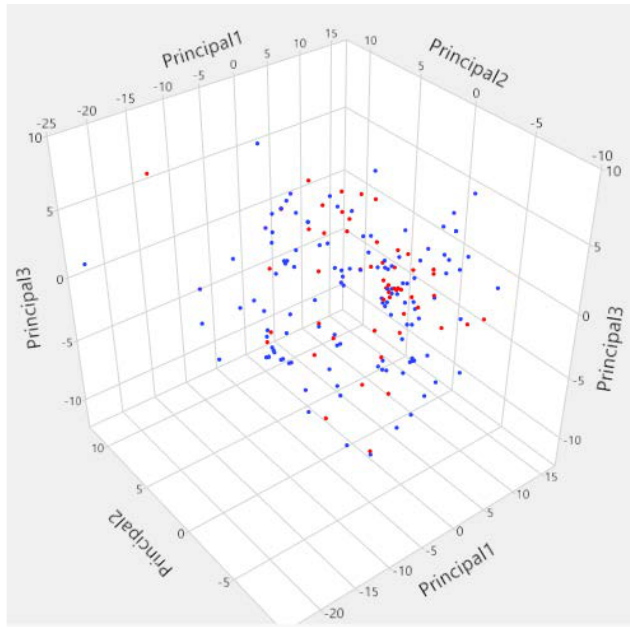
Figure 2. Visualization of descriptors space of Lyn tyrosine kinase inhibitors using principal component analysis (blue points = Training set; red points = test set). Table 1. Representative chemical series of inhibitors of Lyn tyrosine kinase.